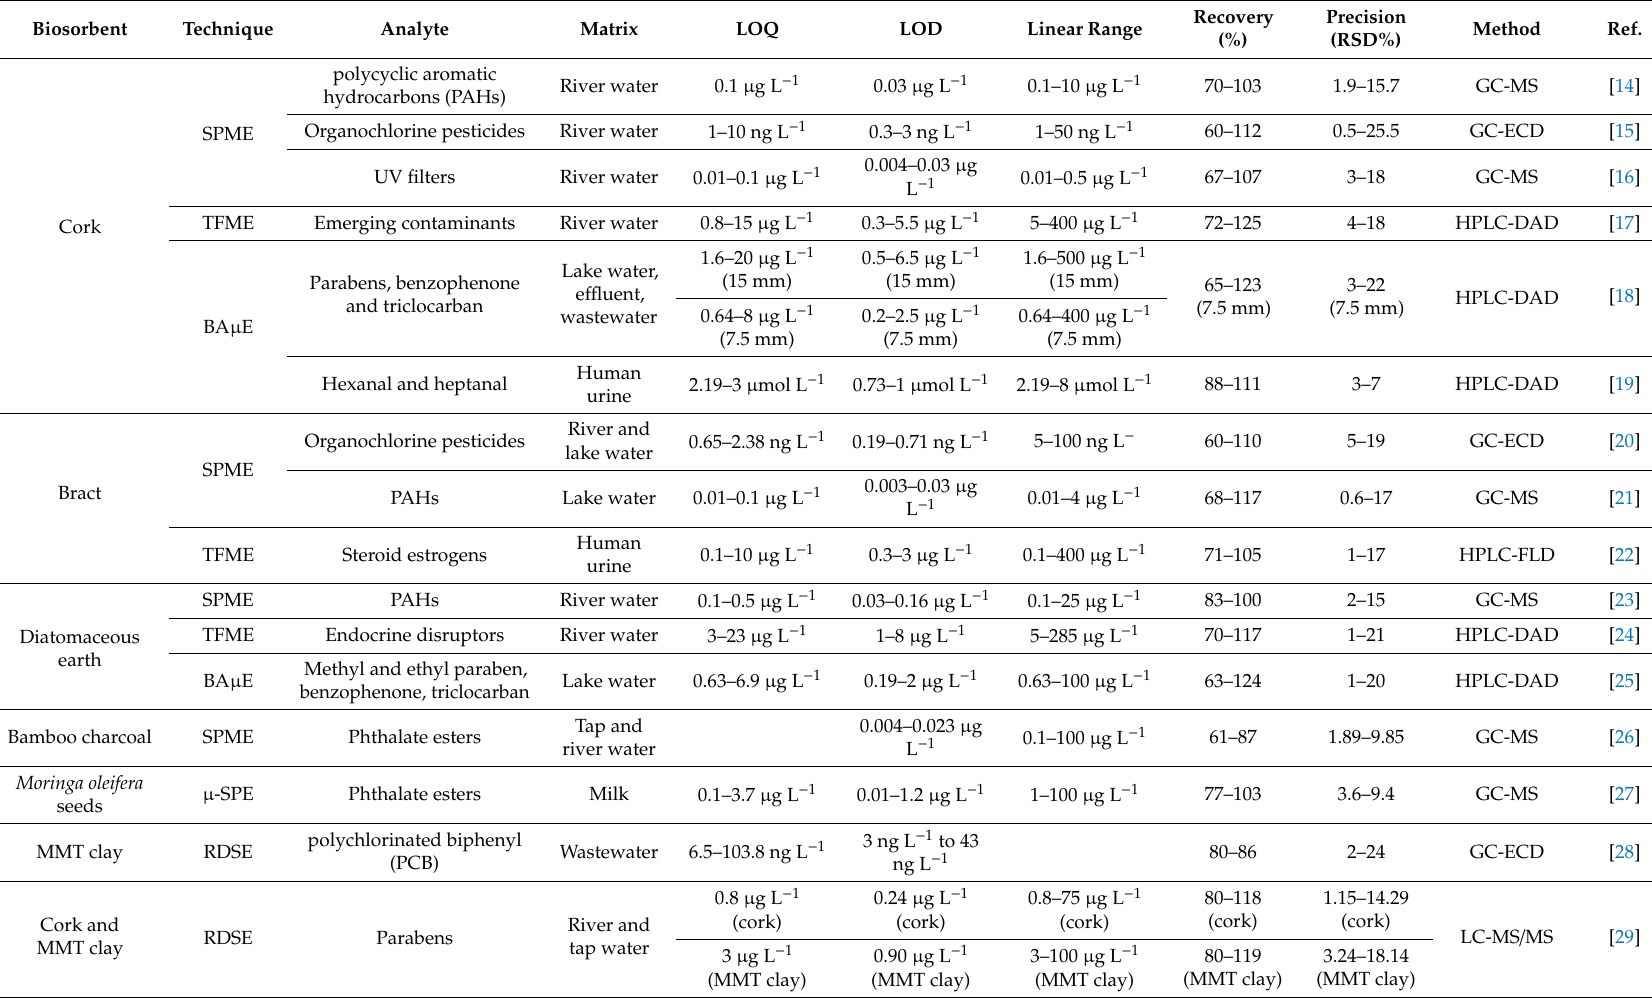
Table 1. Applications and validation parameters of di ff erent microextraction techniques using biosorbents as the extraction phase for organic compound